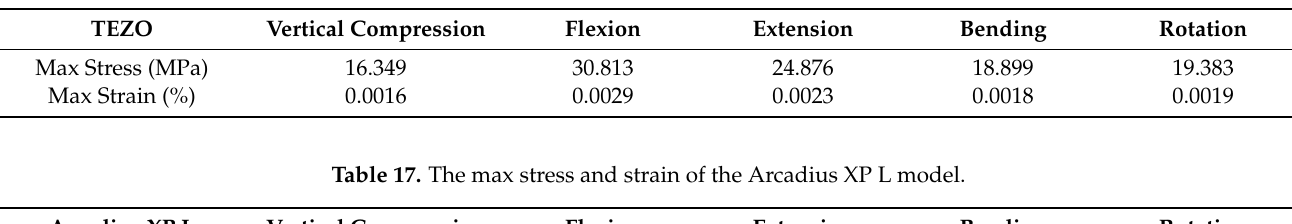
Table 17. The max stress and strain of the Arcadius XP L model.